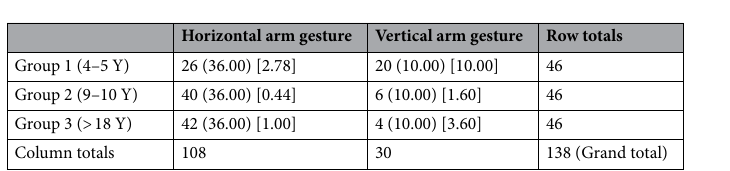
Table 3. The contingency table for the Chi-square test on arm-gesture orientation (the variables were explained in Table 1 caption).